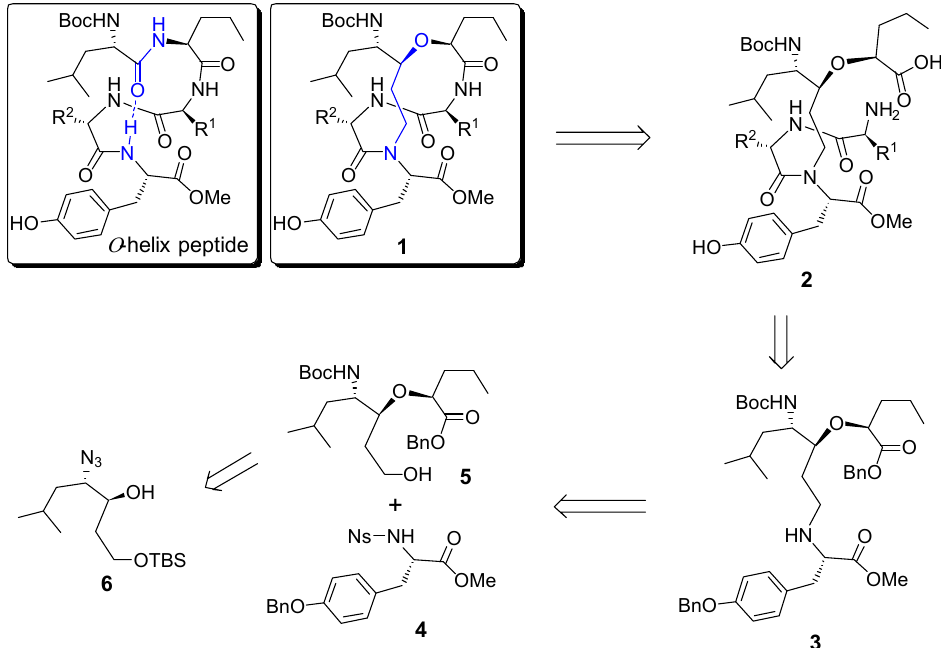
Scheme 1. Structure of α‐ helix peptide and retrosynthetic analysis of helix template 1 .